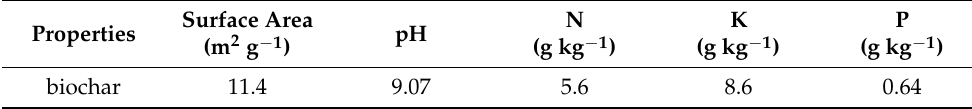
Table 1. The properties of